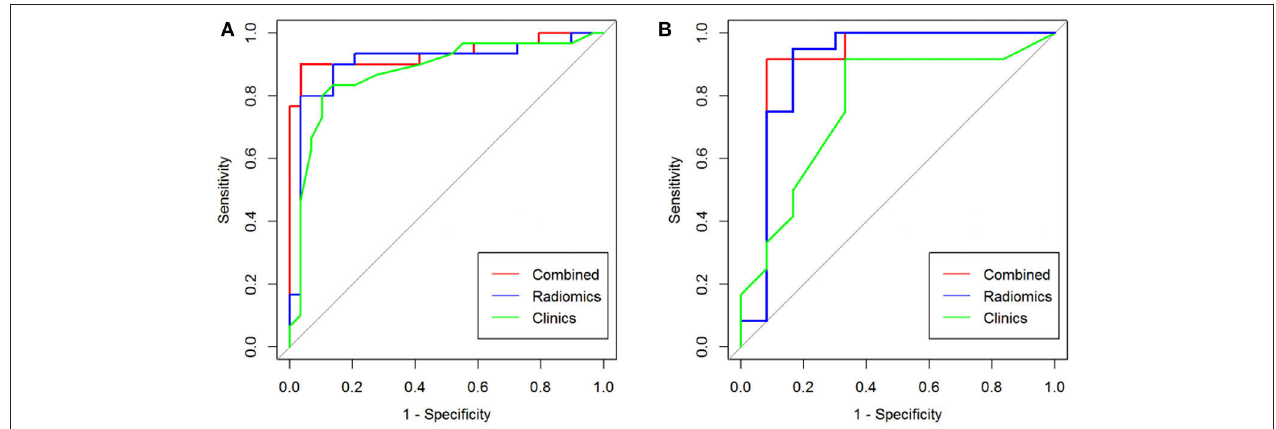
FIGURE 7 | The ROC curve analysis for differential diagnostic efficiency of three models in training cohort (A) and test cohort (B)